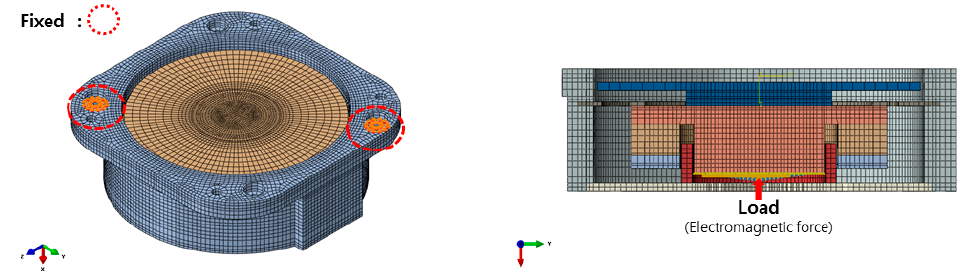
Figure 12. Boundary condition and load condition for vibration analysis.